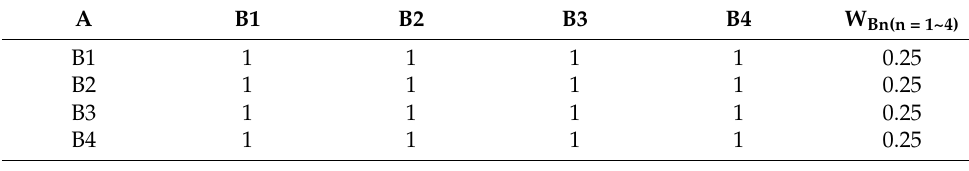
Table A1. A-B Judgment Matrix and Consistency Test.